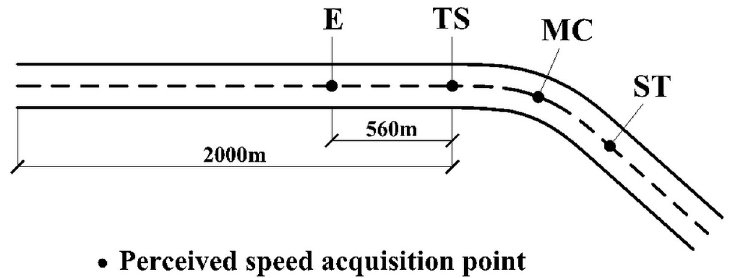
Fig 6. Single curve perceived speed acquisition point and horizontal alignment.